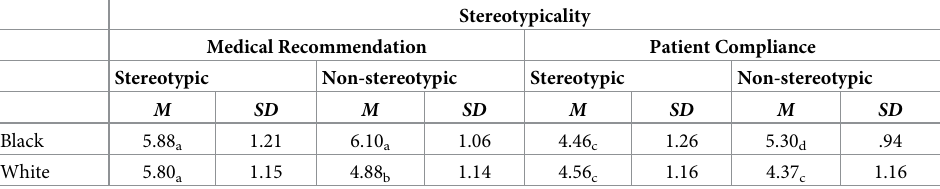
Table 1. Means and standard deviation of responses to medical recommendation and patient compliance